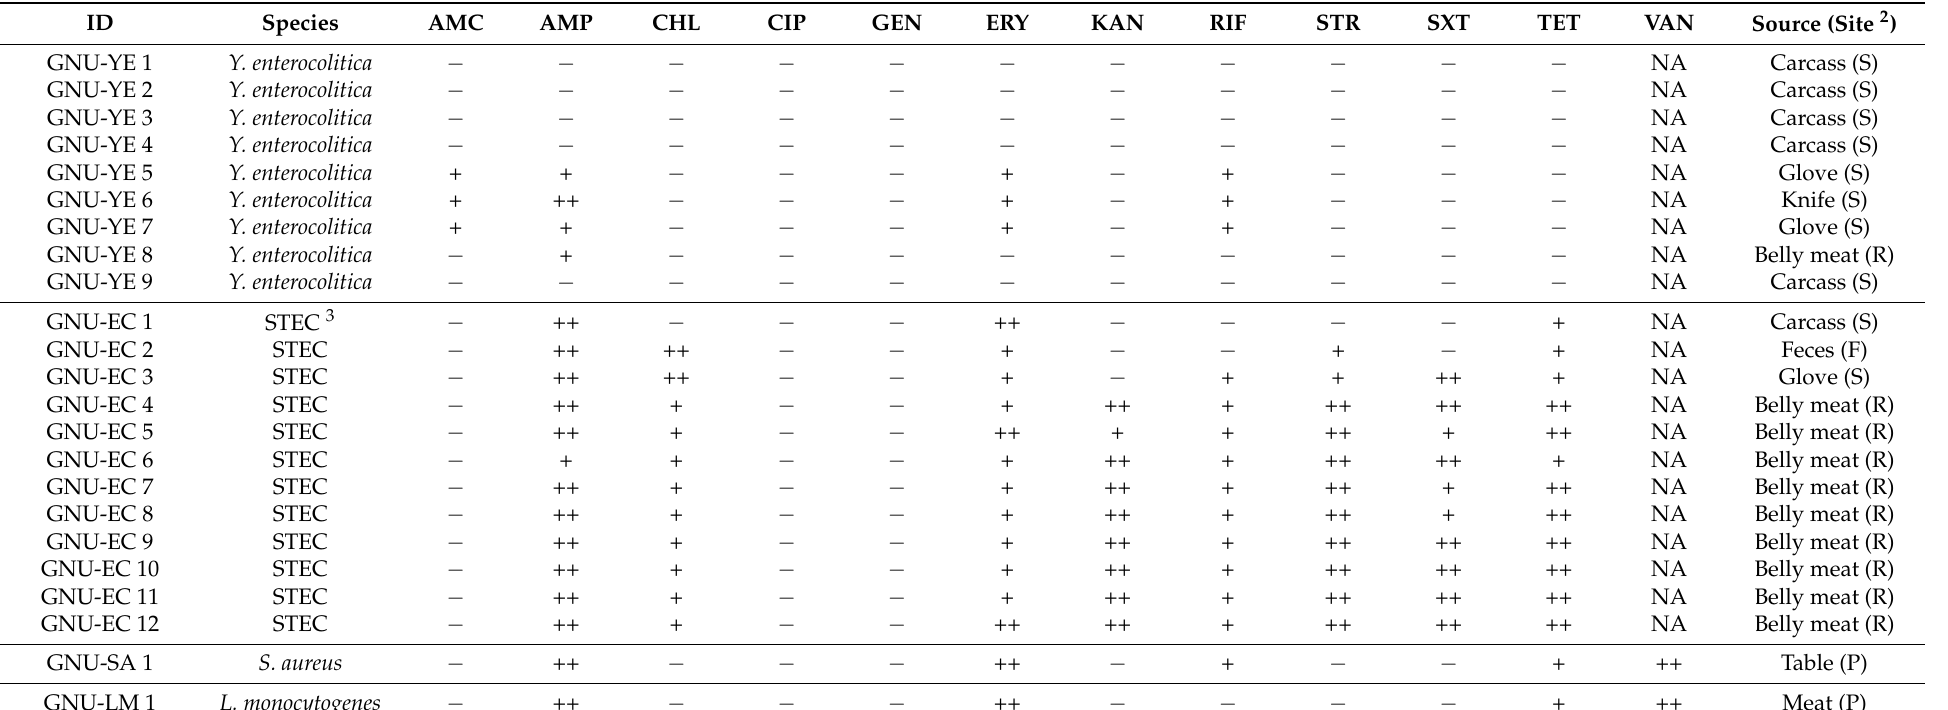
Table 2. Antimicrobial 1 susceptibility test of major pathogens using disc diffusion